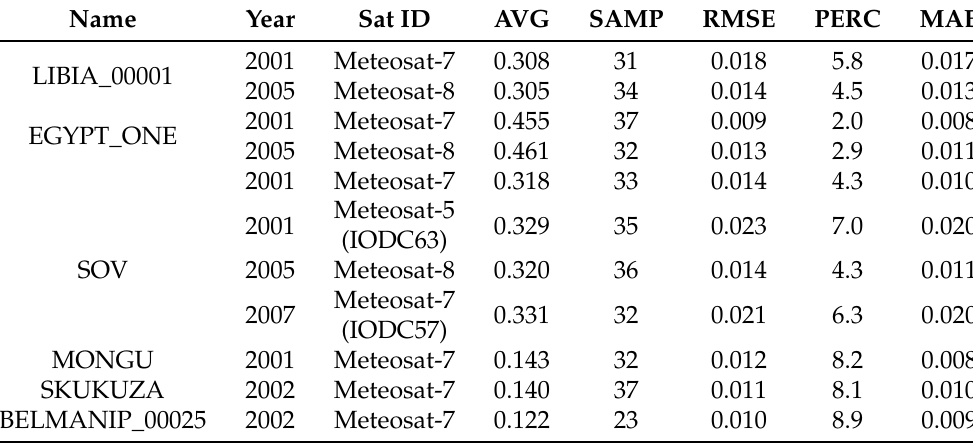
Figure 8. Comparison between DHR30 GSA (Meteosat-8) and MODIS for year 2005 for the site LIBIA_00001. Two GSA and one MODIS retrievals have been flagged as outliers. The results presented in Figure 8 and Table 7 confirm the good agreement between GSA and MODIS, with PERC values for DHR30 ranging between 2% and 7% for bright desert sites, and with value between 8% and 9% for the urban (MONGU), vegetation (BELMANIP_00025), and shrubland (SKUKUZA) sites. The comparison versus SAFARI (see Figure 9 and Table 8) shows a worse agreement, with PERC values of 21%. Although, the comparisons of SAFARI (BHR) versus MODIS and GSA (DHR30) show similar RMSE and PERC values, the MAE value of the comparison versus GSA is higher than the corre- sponding value for MODIS. The latter is an indication of the presence of residual clouds not screened out by the cloud mask, which is confirmed by the significantly higher AVG values of GSA than of MODIS (see Table 7). For the SKUKUZA site the differences between the GSA vs SAFARI and MODIS vs SAFARI are much smaller, with slightly higher RSME, PERC, and MAE values for GSA. The AVG values for GSA and MODIS are almost identical (see Table 8). Table 7. RMSE, PERC and MAE between DHR30 GSA and MODIS for the selected sites and periods. Values are computed using 5 × 5 Meteosat pixels around the site location. AVG is the average DHR30 GSA value over the time-period considered. SAMP is the number of decadal GSA values in the time-period considered. PERC is the ratio between the RMSE and AVG over the time-period considered expressed as